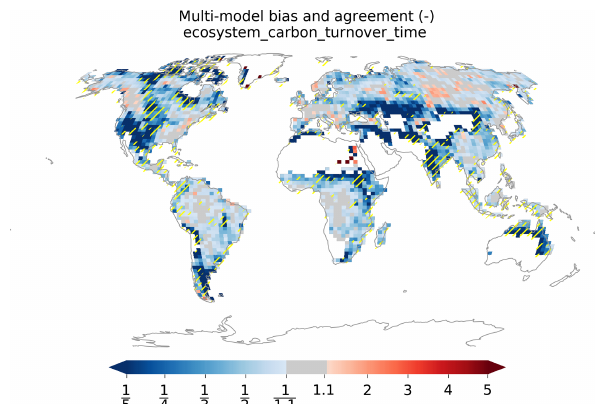
Figure 37. Global distribution of the biases in the multi-model en- semble ecosystem turnover time of carbon (years) and the multi- model agreement in CMIP5 models. The bias is calculated as the ra- tio between multi-model ensemble and observation-based estimate (Carvalhais et al., 2014). The stippling indicates the regions where only two or fewer models (out of 10) are within the range of ob- servational uncertainties (5th and 95th percentiles). Produced with recipe_carvalhais2014nat.yml ; see details in Sect.